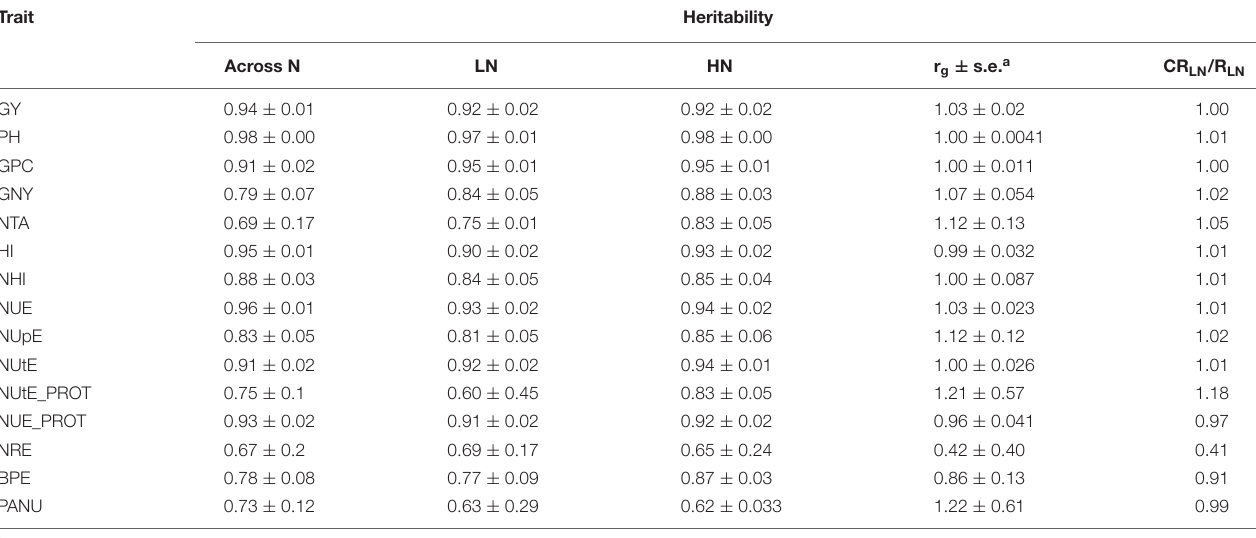
TABLE 4 | Heritability and genetic correlations ( r g ) estimates of analyzed traits at two nitrogen levels and across six environments and 48 wheat cultivars and efficiency of indirect selection under HN for performance under LN relative to the predicted response to direct selection under LN (CR LN /R LN ) for 15 traits. Trait Heritability